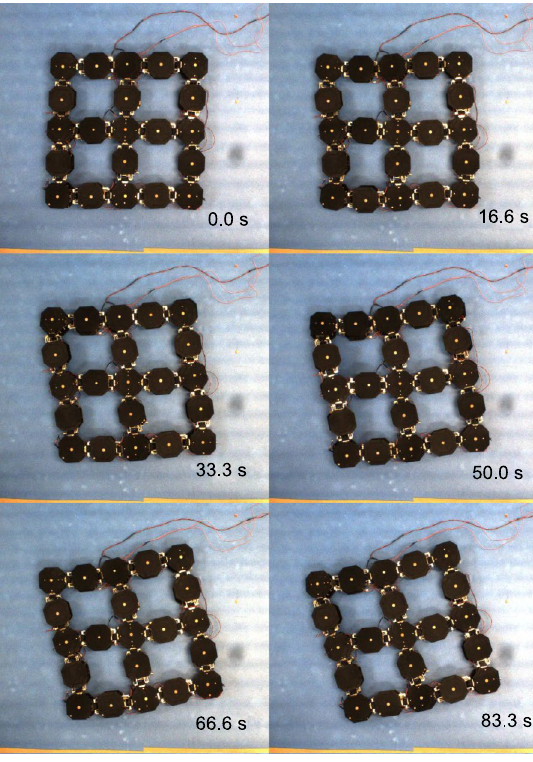
Fig. 18 Spinning locomotion of WORMESH-II (wave parameters are A = 0.12 π , ω = π/ 20 , and β = 3 π/ 2 )